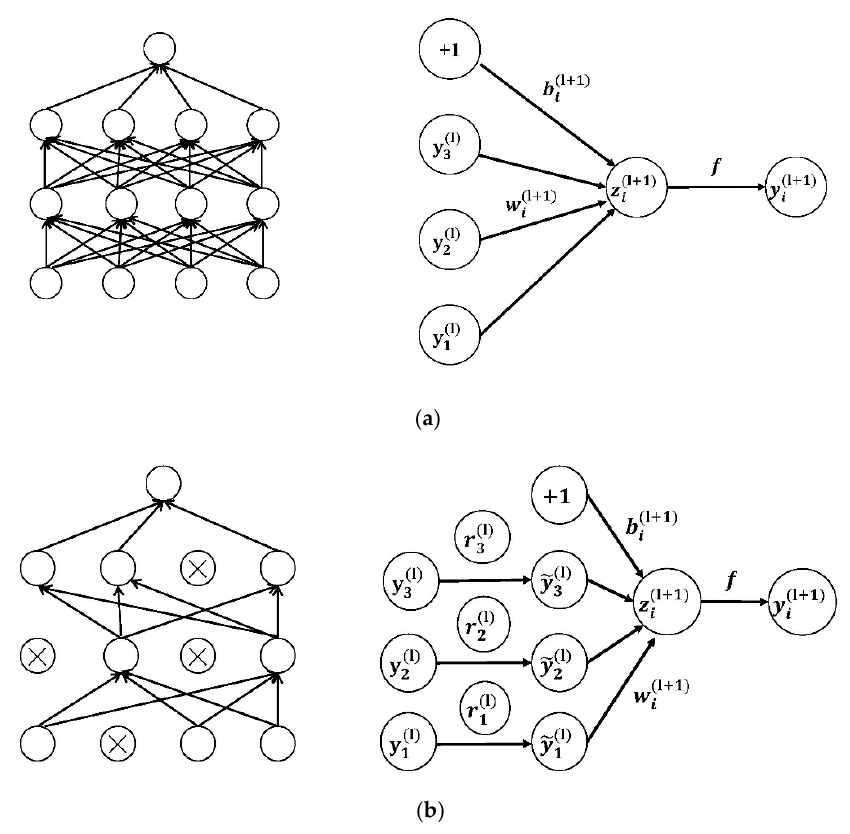
Figure 7. ( a ) The networks not using dropout; ( b ) the networks using dropout [38].